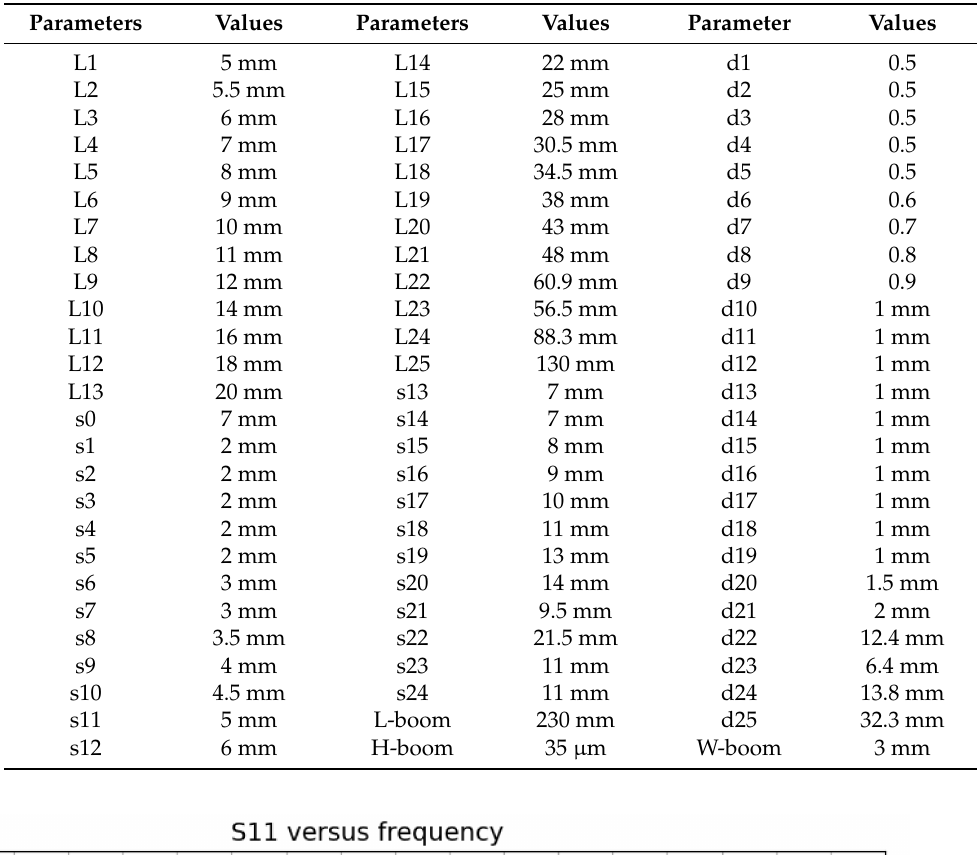
Table 4. Dimensions of the improved PLPDA antenna.